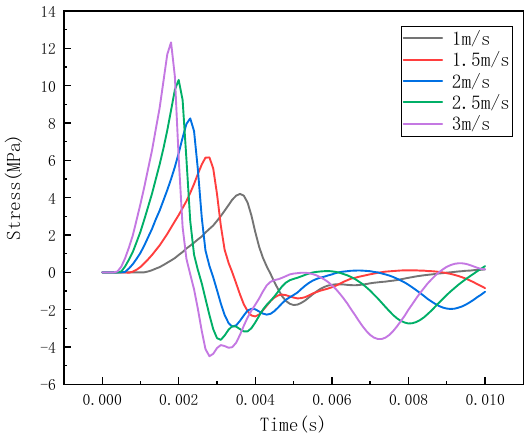
Figure 11. Stress curve of detection point at impact at position 2.